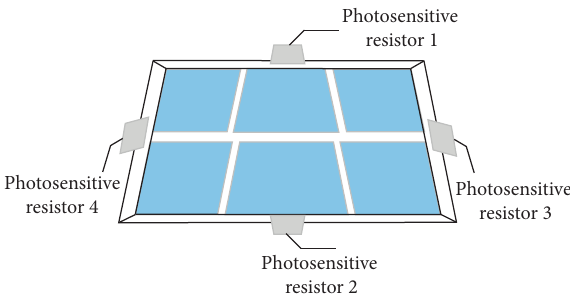
Figure 4: Position of photosensitive resistor.